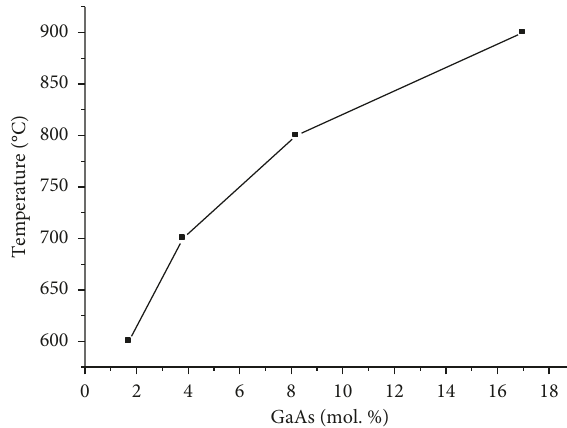
Figure 3: Dependence of the solubility of GaAs in Sn on temperature.